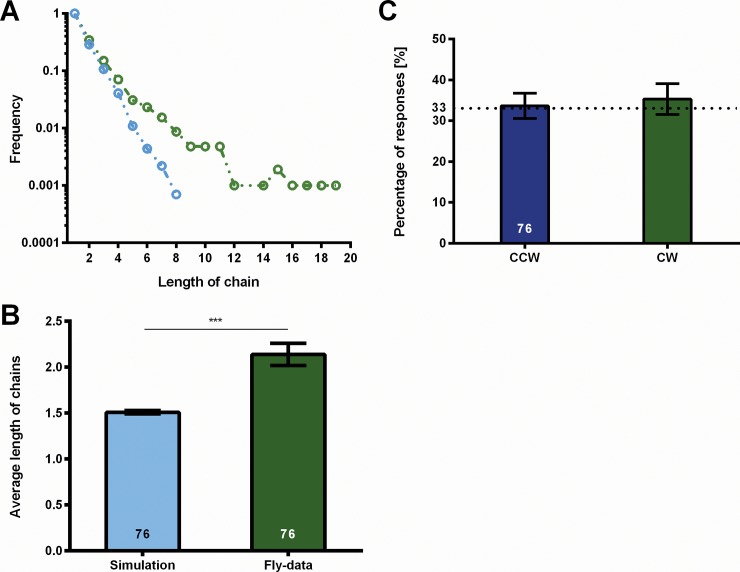
Response frequencies and chain lengths.Chains are consecutive identical responses. (A) Frequencies of chain lengths. The green line represents frequencies of chains of certain lengths. The blue line shows the chain length frequencies calculated from the mean response frequencies shown in (B) assuming random choices. (C) Average lengths of chains. Calculated mean chain length differs significantly from measured one. Error bars are SEMs (*P < 0.05, **P < 0.01, ***P < 0.001).